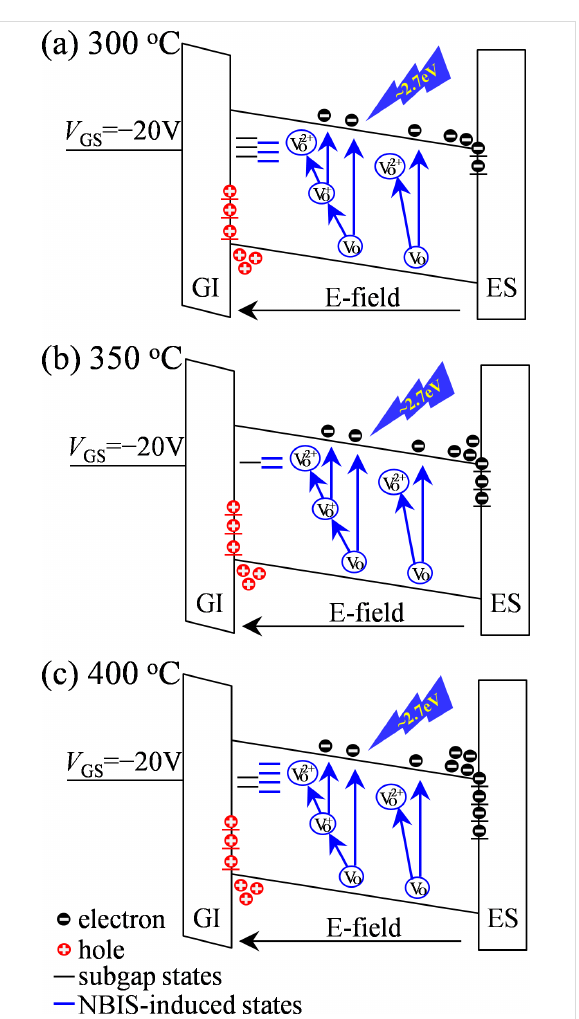
Figure 5: Possible degradation mechanisms of NBIS-induced insta- bility in the devices annealed at (a) 300, (b) 350, and (c) 400 °C, re-